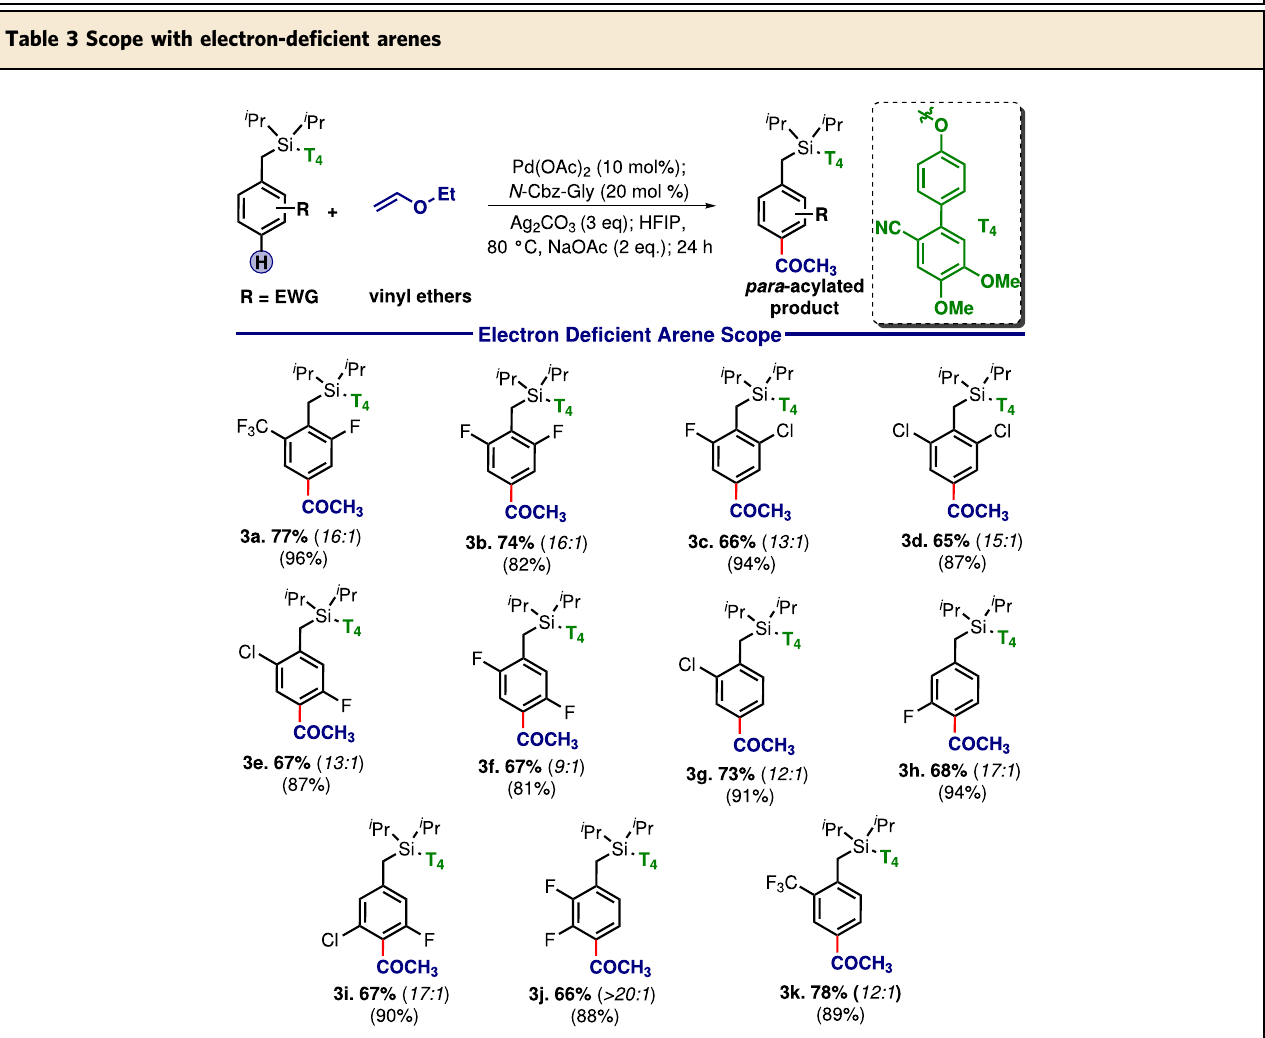
Table 3 Scope with electron-de fi cient